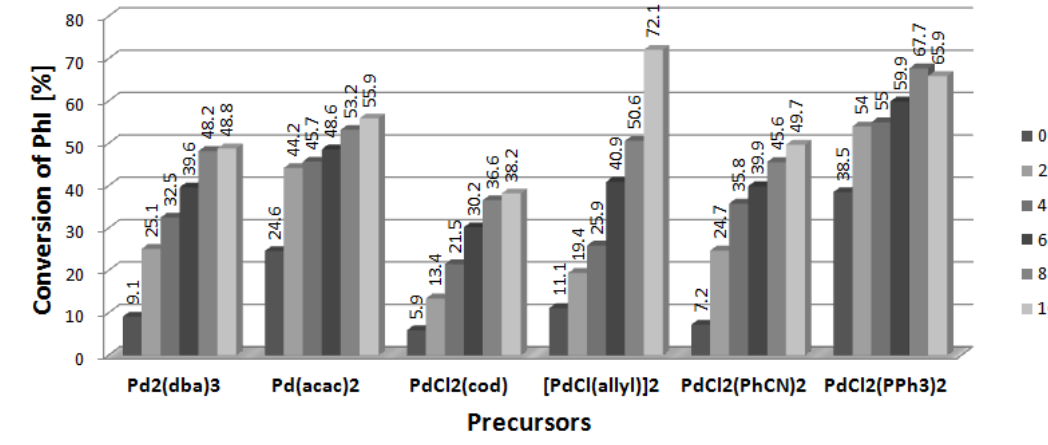
Figure 6. Heck arylation of DHF catalyzed by [PdCl(allyl)]